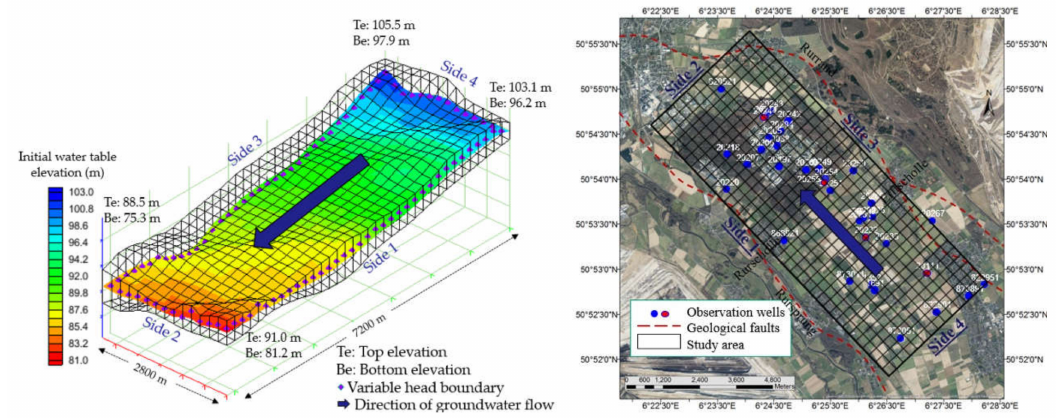
Figure 6. The initial water table elevation, MODFLOW grids, boundary condition, the general groundwater flow direction (the blue arrow), and the thickness of the aquifer at four boundary